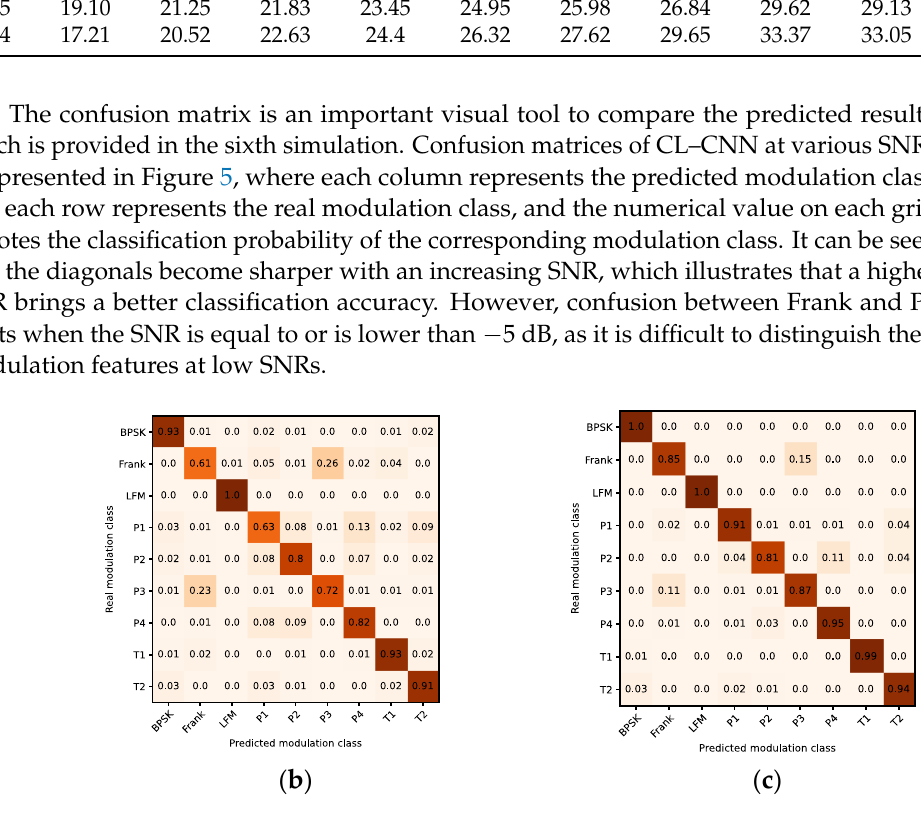
Figure 5. Confusion matrices of the CL–CNN model at different SNRs: ( a ) SNR -10dB, ( b ) SNR-5dB, ( c ) SNR 0dB.